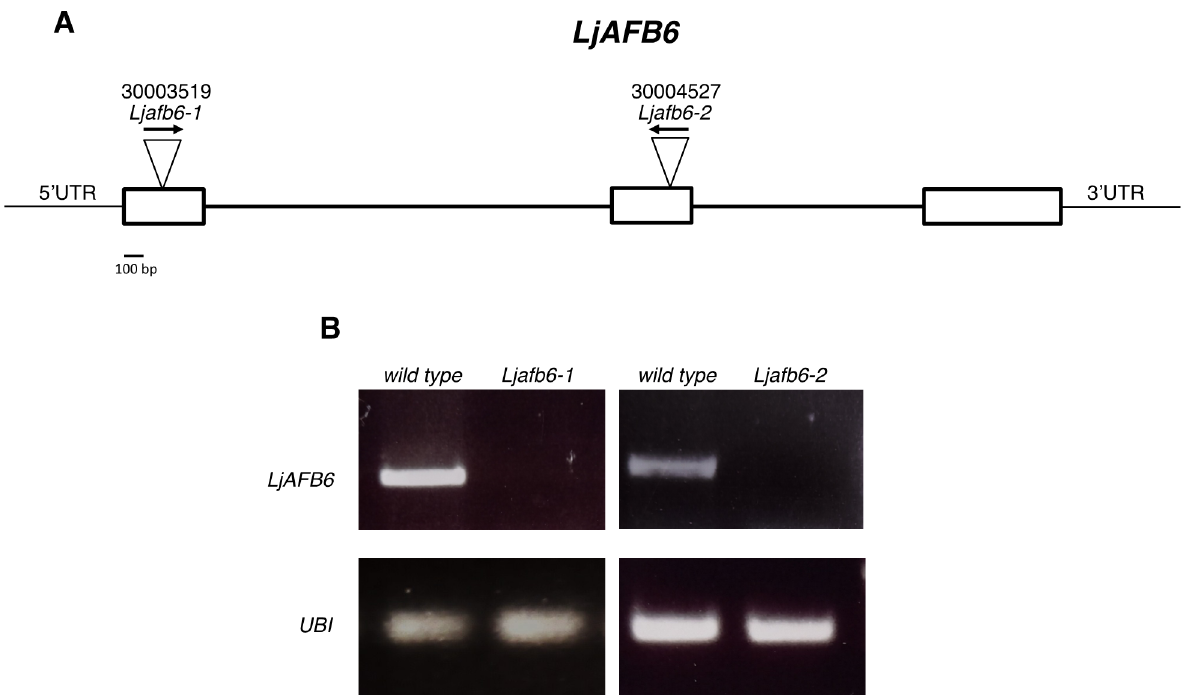
Figure 5. Structure of the L. japonicus AFB6 gene and analysis of the expression in the LORE1 segregants. ( A ) Gene model of LjAFB6 . Insertion sites and relative orientations of the LORE1 retrotransposon element in the 30003519 and 30004527 lines are indicated. ( B ) Expression of the LjAFB6 gene in the Ljafb6-1 and Ljafb6-2 plants. Total RNAs isolated from leaves was used for qRT-PCR analyses.